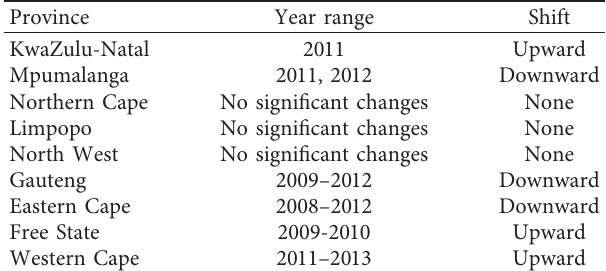
Figure 19: Northwest murder: CUSUM Table 10: Occurrence of the potential abrupt